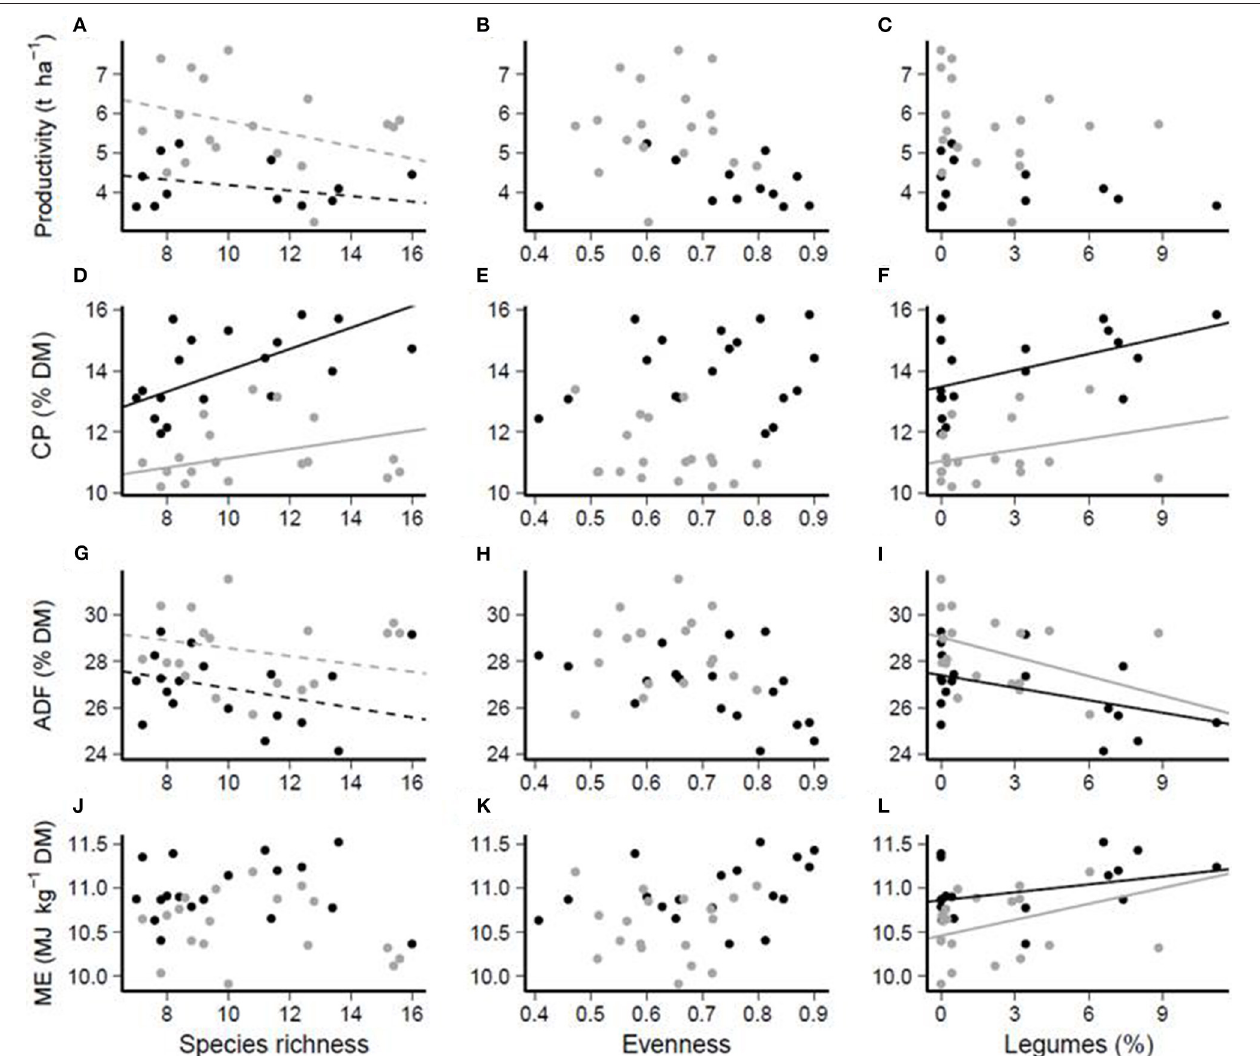
FIGURE 2 | (A–L) Functional relationship between species richness (first column), evenness (second column), or legume proportion (%, third column) and productivity (first row), CP (crude protein, second row, % DM), ADF (acid detergent fiber, third row, % DM), or ME (metabolizable energy, fourth row, MJ ME kg − 1 DM) concentrations, respectively. Black dots: year 2010, gray dots: year 2011. Solid lines indicate a significant relationship ( P < 0.05) and dashed lines a trend ( P < 0.1). Interactions between year and predictor were in no case significant.